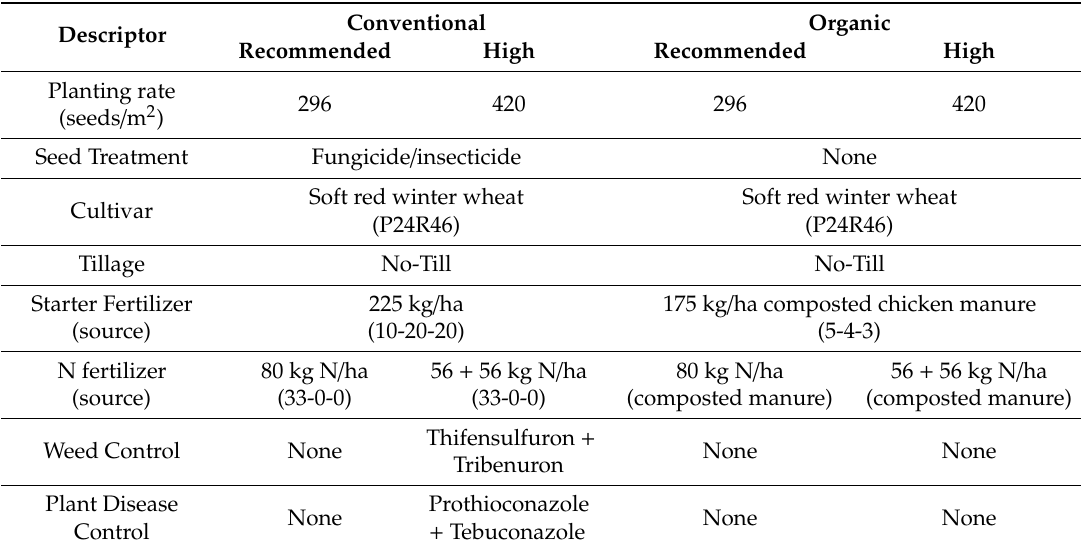
Table 1. Planting rate, seed treatment, cultivar, tillage, starter fertilizer, N fertilizer, weed control, and plant disease control practices for wheat in conventional and organic cropping systems with two management inputs (recommended and high input) in 2016 and 2018 at a University Research Farm in central New York,